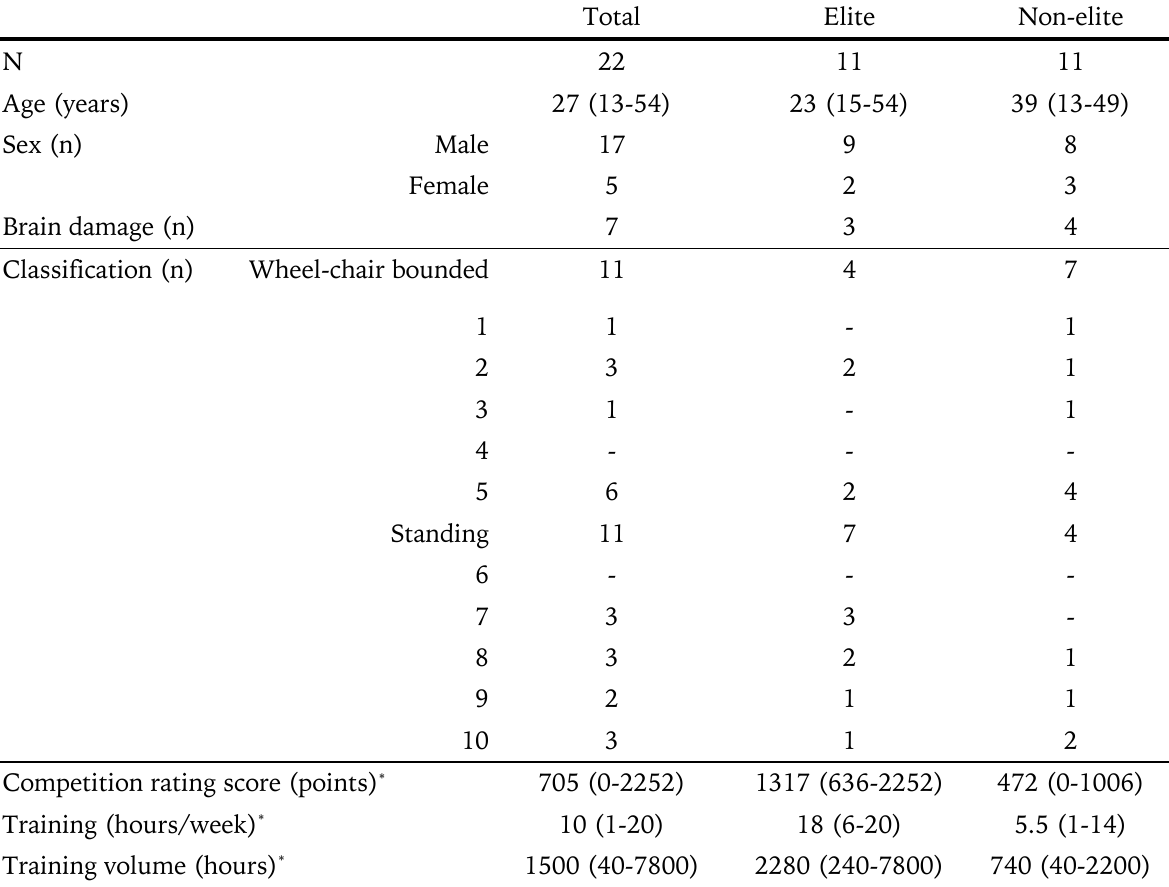
Table 1. Characteristics of the included para table tennis